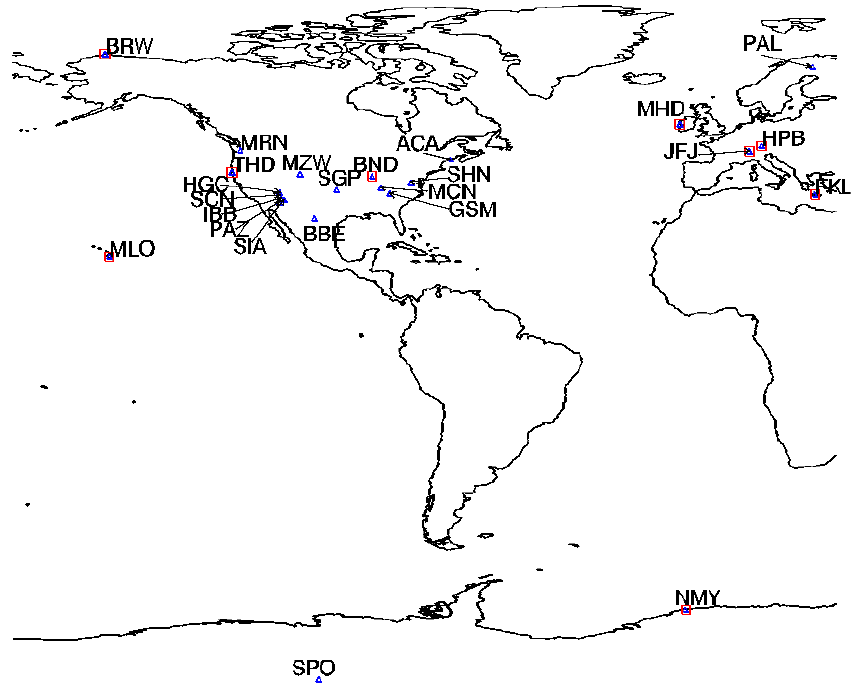
Fig. 1. Map of sites; blue triangles indicate sites with scattering data used in this paper, red squares indicate sites with absorption data used in this